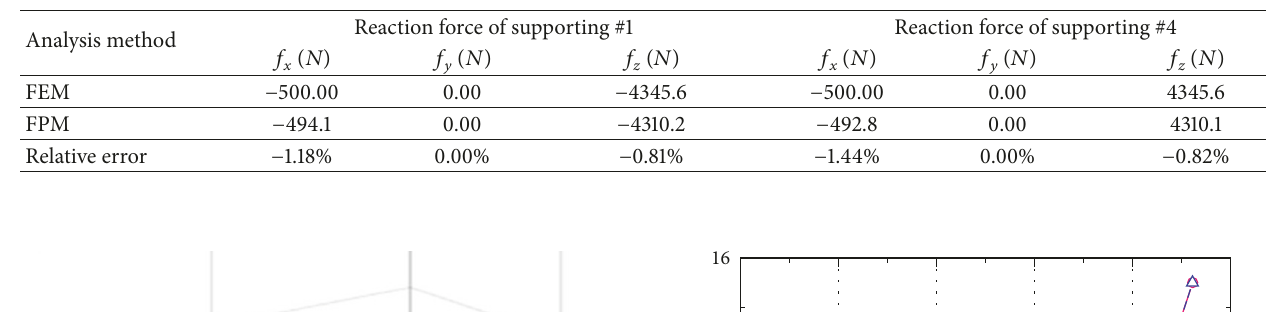
Table 2: Supporting reaction force under horizontal concentrated load.